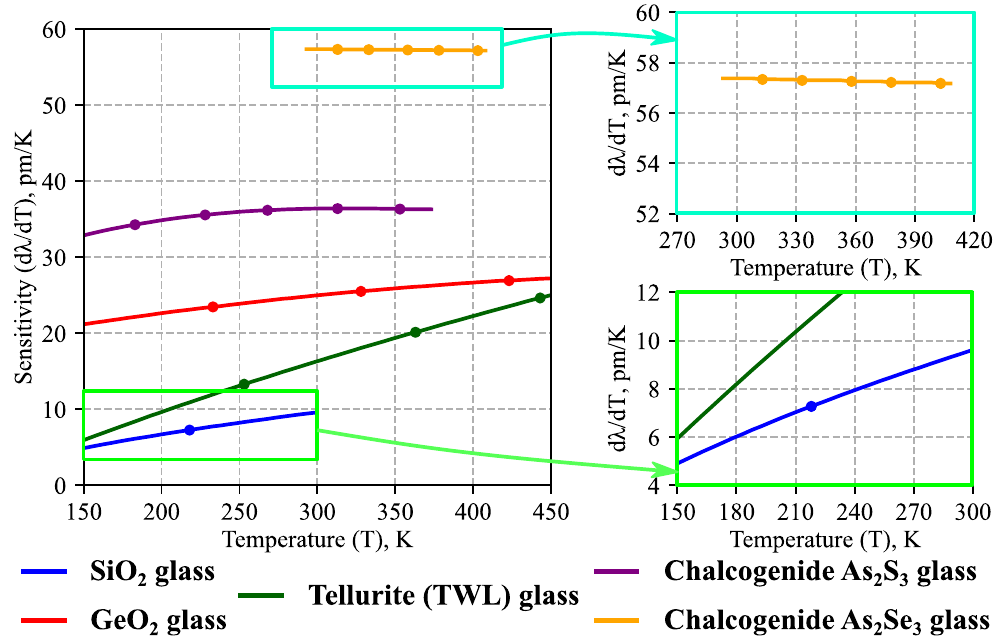
Figure 3. Calculated temperature sensitivities d λ / dT of spherical microresonators based on different glasses as a function of ambient temperature. The data are shown only for TE fundamental WGMs that are the closest to λ = 1.55 μ m for the corresponding T ; line segments between dots denote different operating WGMs. Room temperature ( T 0 = 293 K) microsphere radius is R 0 = 100 μ m.